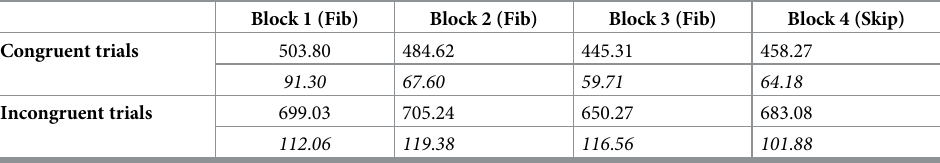
Table 1. Mean ( Standard Deviation ) reaction times in each condition for each block for congruent and incongru- ent trials (Analysis